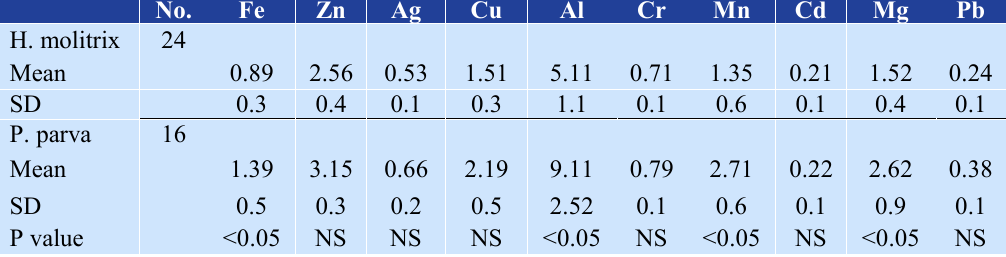
Table 2. Trace elements (Mean and SD) in the muscle of two fish in Zarivar wetland No. Fe Zn Ag Cu Al Cr